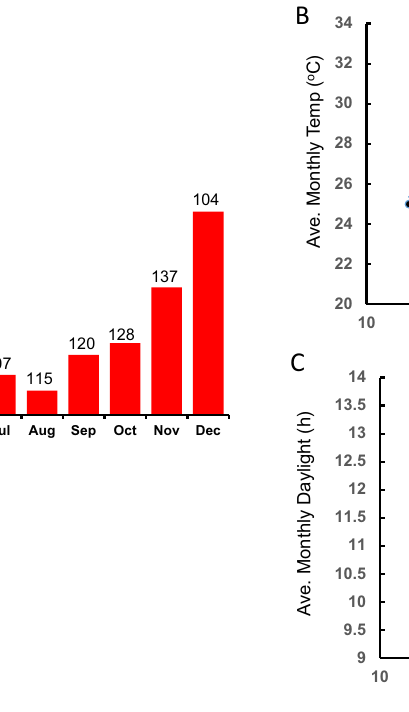
Figure 2. Seasonal variation in the semen quality of 1271 bull semen ejaculates. Semen samples were taken from bulls via electroejaculation and a full semen analysis was undertaken. Each sample was then classified as a pass or fail as described in Materials and Methods. ( A) The percentage failure rate for each month is shown for all bulls. The number above each column indicate how many semen ejaculates were processed that month. ( B). Scatter plot showing the average monthly temperature of Rockhampton and the percentage of samples that fail/month. Line of best fit indicates and r 2 = 0.55. ( C) Scatter plot showing the average daily sunlight in Rockhampton and the percentage of samples that fail/month. Line of best fit indicates and r 2 = 0.04.